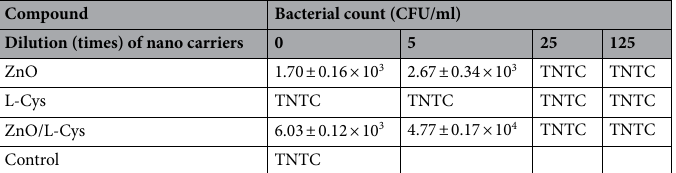
Compound Bacterial count (CFU/ml) Dilution (times) of nano